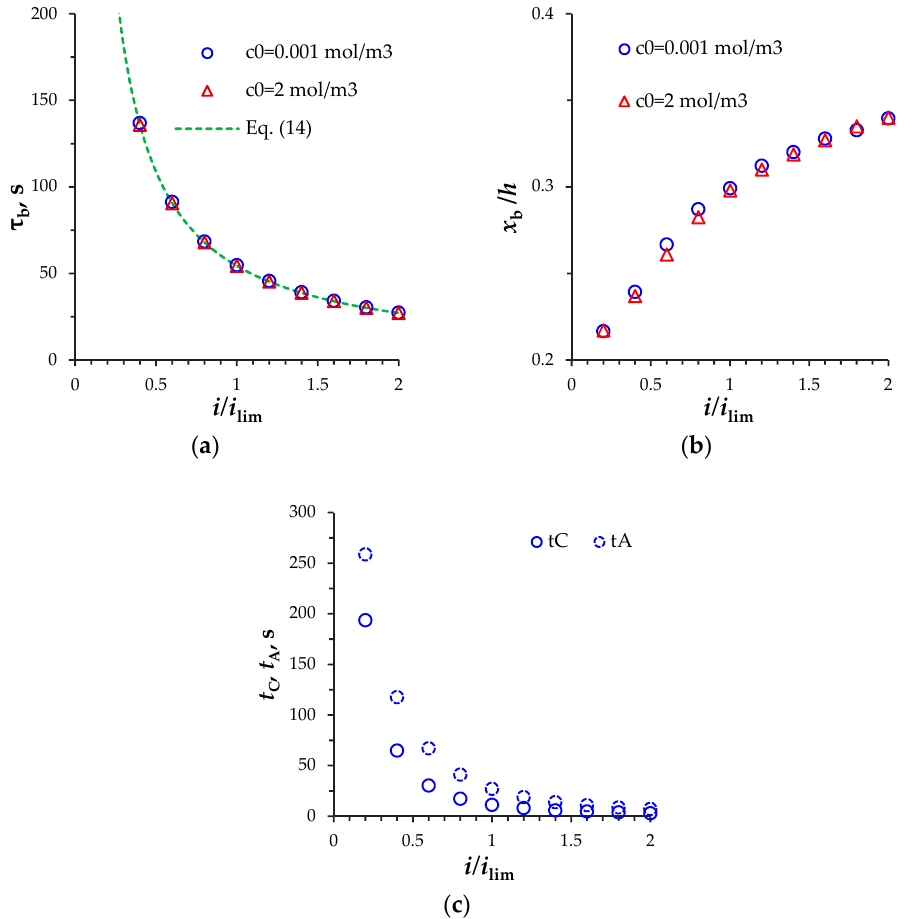
Figure 5. ( a ) The space-charge breakdown time, τ b calculated by the model (markers) and by Equation (14) (dashed line); ( b ) distance from the AEM to the local minimum of the SCR before the discharge, x b ; ( c ) the time of the appearance of local extrema of the SCRs at the AEM, t A , and CEM, t C . Results for T 2C = T 1A = 0.03, c 0 = 0.001 mol/m 3 (round markers) and c 0 = 2 mol/m 3 (triangular markers).